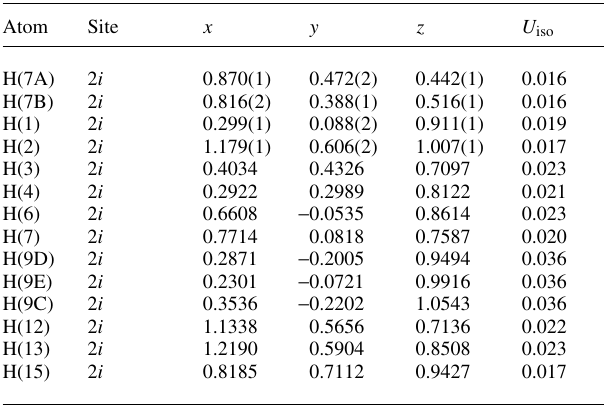
Table 2. Atomic coordinates and displacement parameters (in Å 2 )